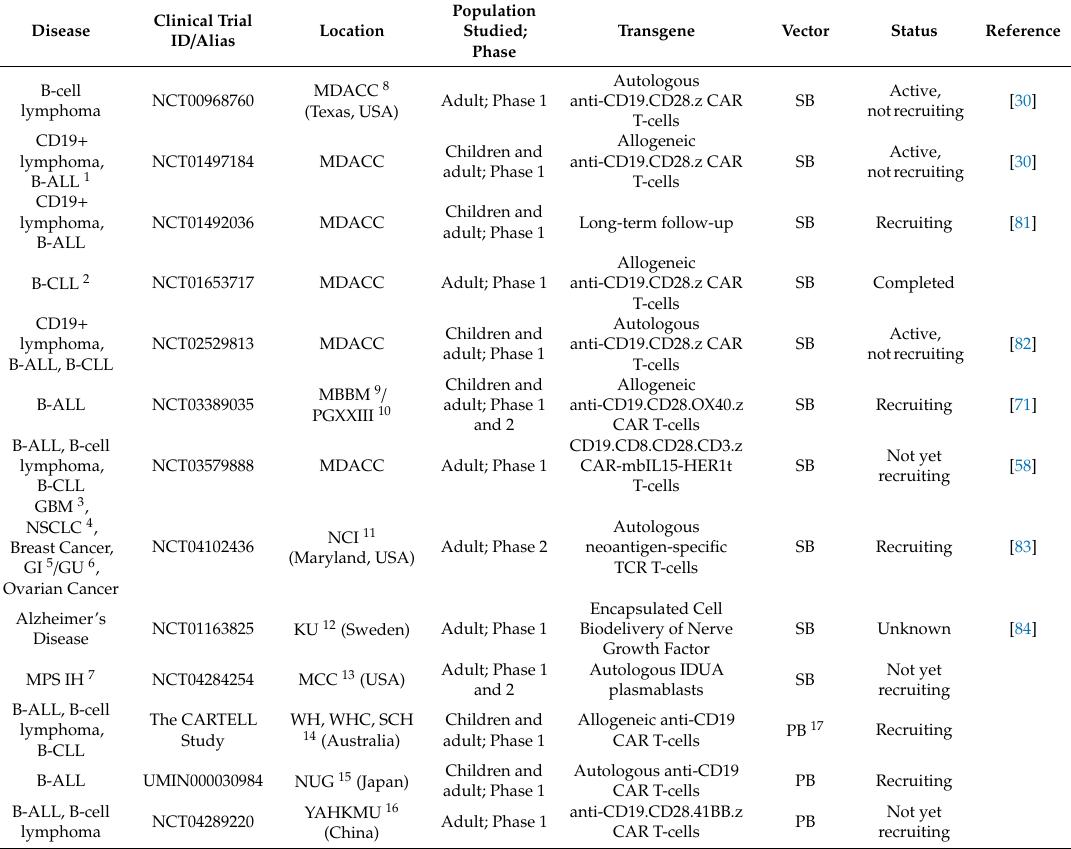
Table 2. Active, recruiting and completed clinical trials using transposon-mediated gene